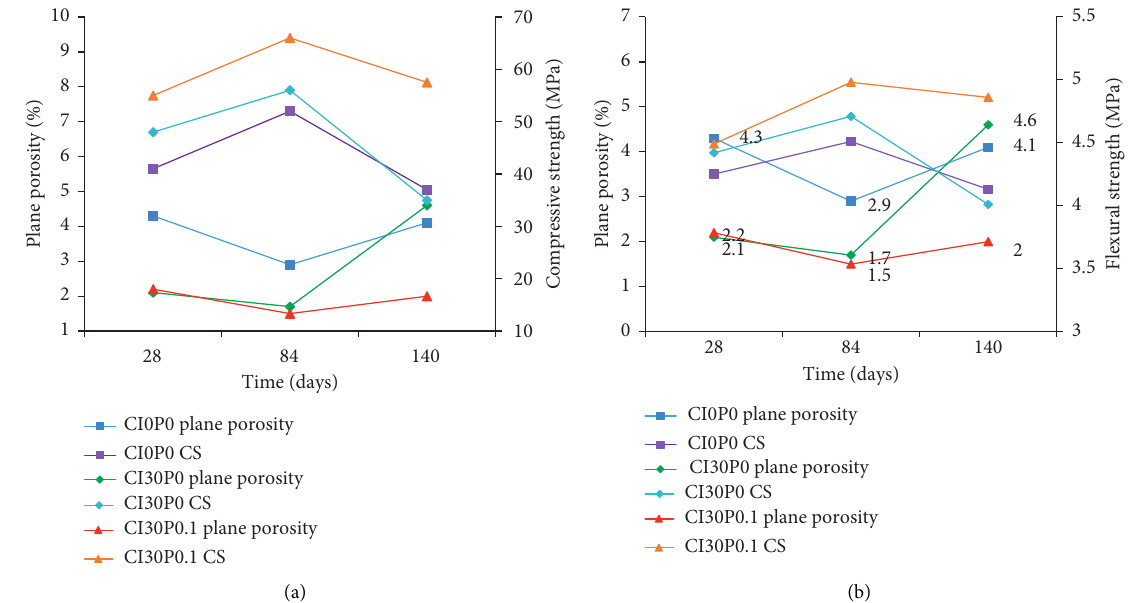
Figure 16: Changes in mechanical properties and plane porosity. CS, compressive strength. FS, flexural strength. (a) Compressive strength and plane porosity. (b) Flexural strength and plane